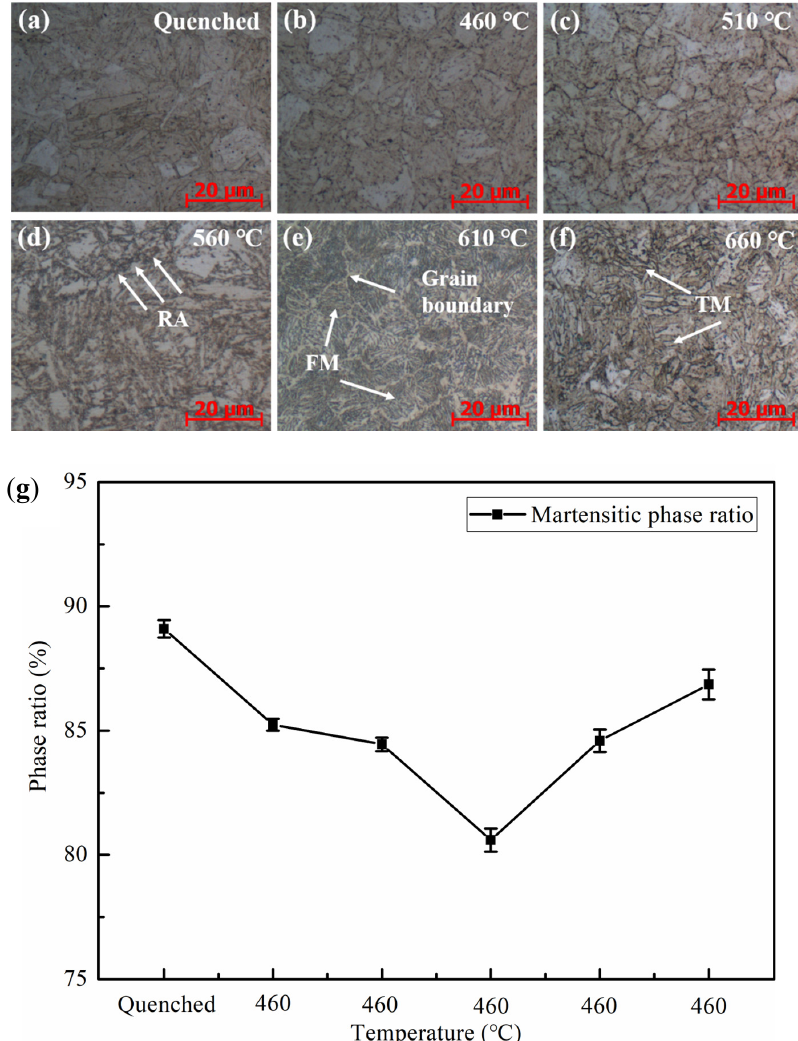
Figure 6. OM images of the Fe-9Ni-2Cu steel with the increase of temperatures. ( a ) Quenched; ( b ) 460 °C; ( c ) 510 °C; ( d ) 560 °C; ( e ) 610 °C; ( f ) 660 °C; ( g ) phase ratio.